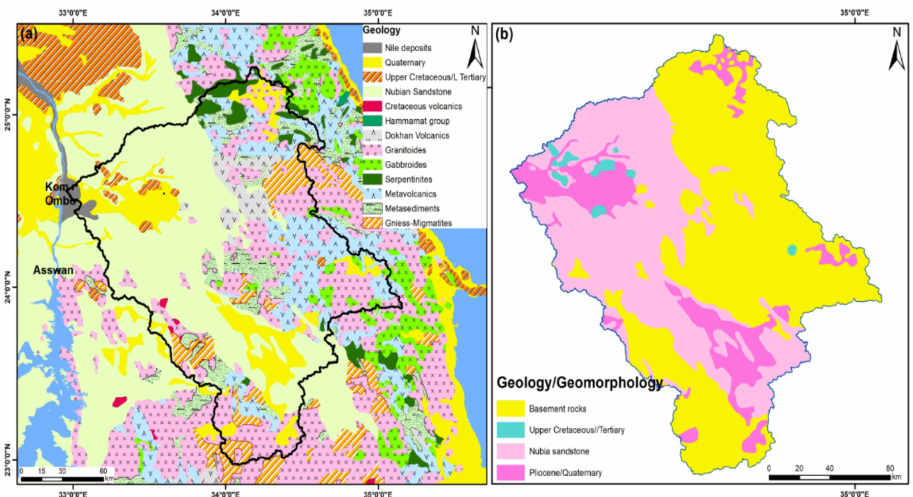
Figure 3. ( a ) Geologic map [26] of the studied area of east Kom Ombo; ( b ) simplified geologic density